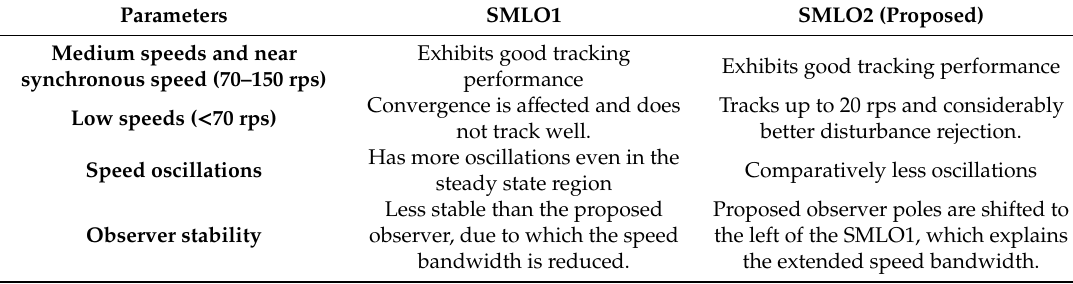
Figure 17. Pole placement of SMLO1 and SMLO2. Table 2. Performance